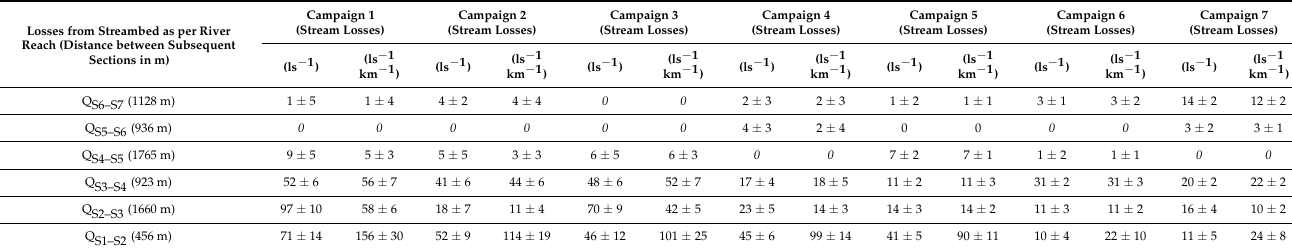
Table 3. Losses from streambed (in ls − 1 and ls − 1 km − 1 along with the corresponding uncertainties calculated with the error propagation method presented by [33]). The losses from streambed that have been forced to 0 are in italics. LossesfromStreambedasperRiver Reach(DistancebetweenSubsequent